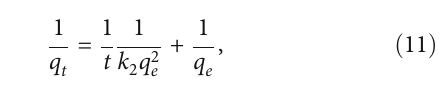
2 cess. The linear plots of 1/ q vs. time 1/ t shown in t Figure 8(b) give the values of k and q . It could be seen that 2 e samples: TiO -5%Co, TiO -1%Co-2.5%Fe, and three TiO 2 2 2 TiO -2.5%Co-2.5%Fe showed the best fi t in the linear plots 2 vs. 1/ t with higher values of R 2 (0.83, 0.95, and of 1/ q t 0.99, respectively) than those of the pseudo- fi rst-order equa- tion (0.78, 0.85, and 0.98). The values of q obtained from e the linear plots are 9.03 mg · g -1 , 18.28 mg · g -1 , and 21.78 mg · g -1 for TiO -5%Co, TiO -1%Co-2.5%Fe, and 2 2 TiO -2.5%Co-2.5%Fe, which were higher than those of the 2 experimental values (8.75 mg · g -1 , 14.86 mg · g -1 , and 15.75 mg · g -1 for TiO -5%Co, TiO -1%Co-2.5%Fe, and 2 2 TiO -2.5%Co-2.5%Fe, respectively), whereas the undoped 2 TiO , TiO -1%Co, and TiO -2.5%Co samples did not follow 2 2 2 the pseudo-second-order equation because of smaller values of R 2 (0.82, 0.55, and 0.54) of the plots 1/ q vs. 1/ t (not t shown), compared to those of the pseudo- fi rst-order plots. The observations revealed that the degradation of MB on the undoped TiO and Co single-doped TiO samples with 2 2 1% Co and 2.5% Co doping can be described by the pseudo- fi rst-order equation. Meanwhile, the pseudo-second order fi ts better compared to the pseudo- fi rst order for